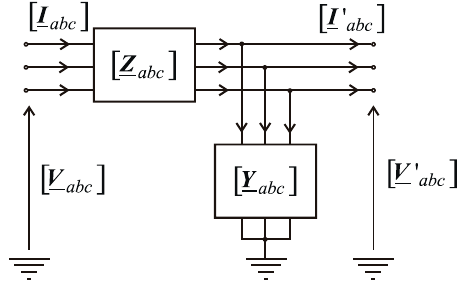
Figure 6. The equivalent octopole of the line used for power flow calculation in the phase components.